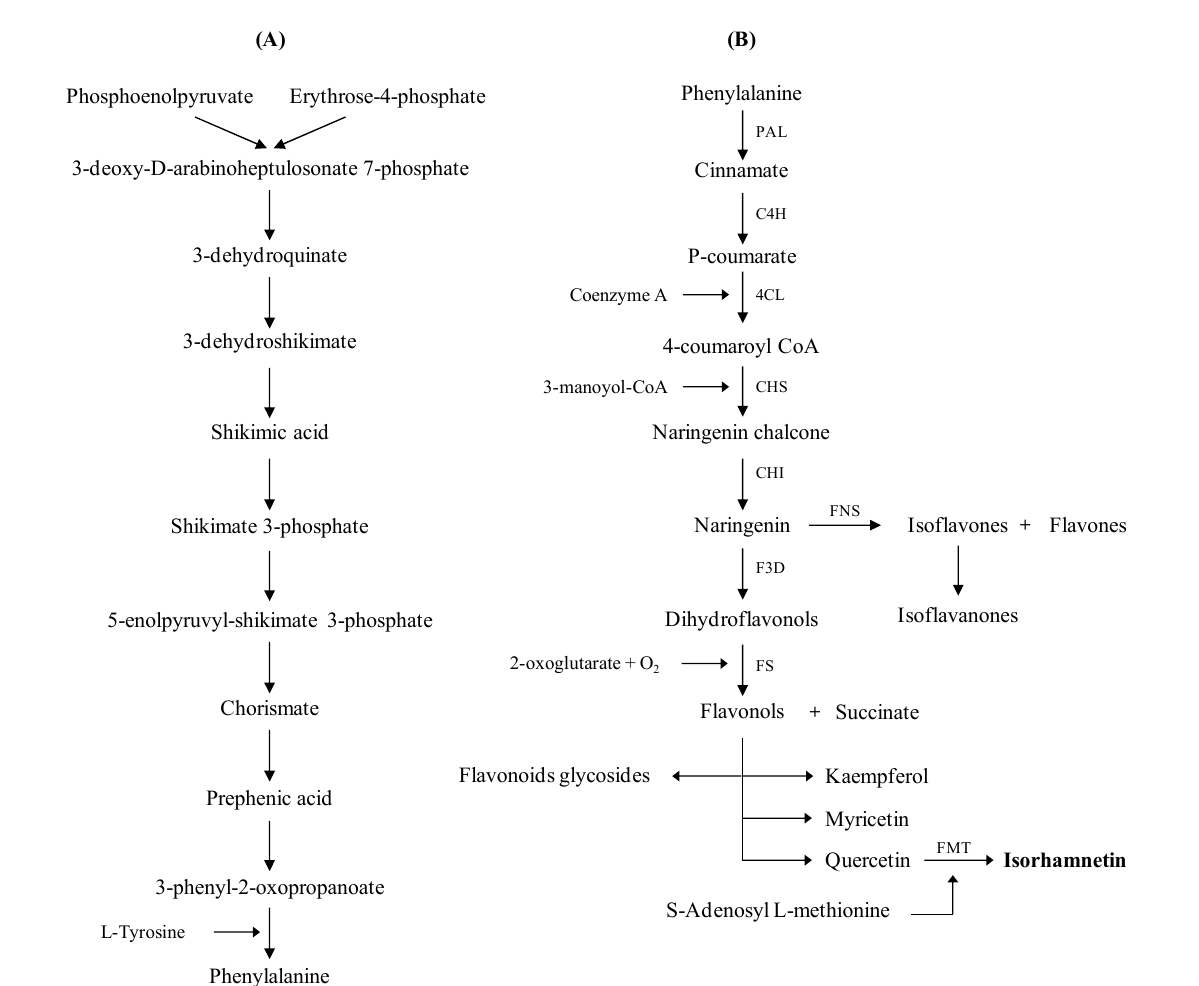
Figure 1. Simplified biosynthetic of isorhamnetin by ( A ) the shikimic and ( B ) the phenylpropanoid